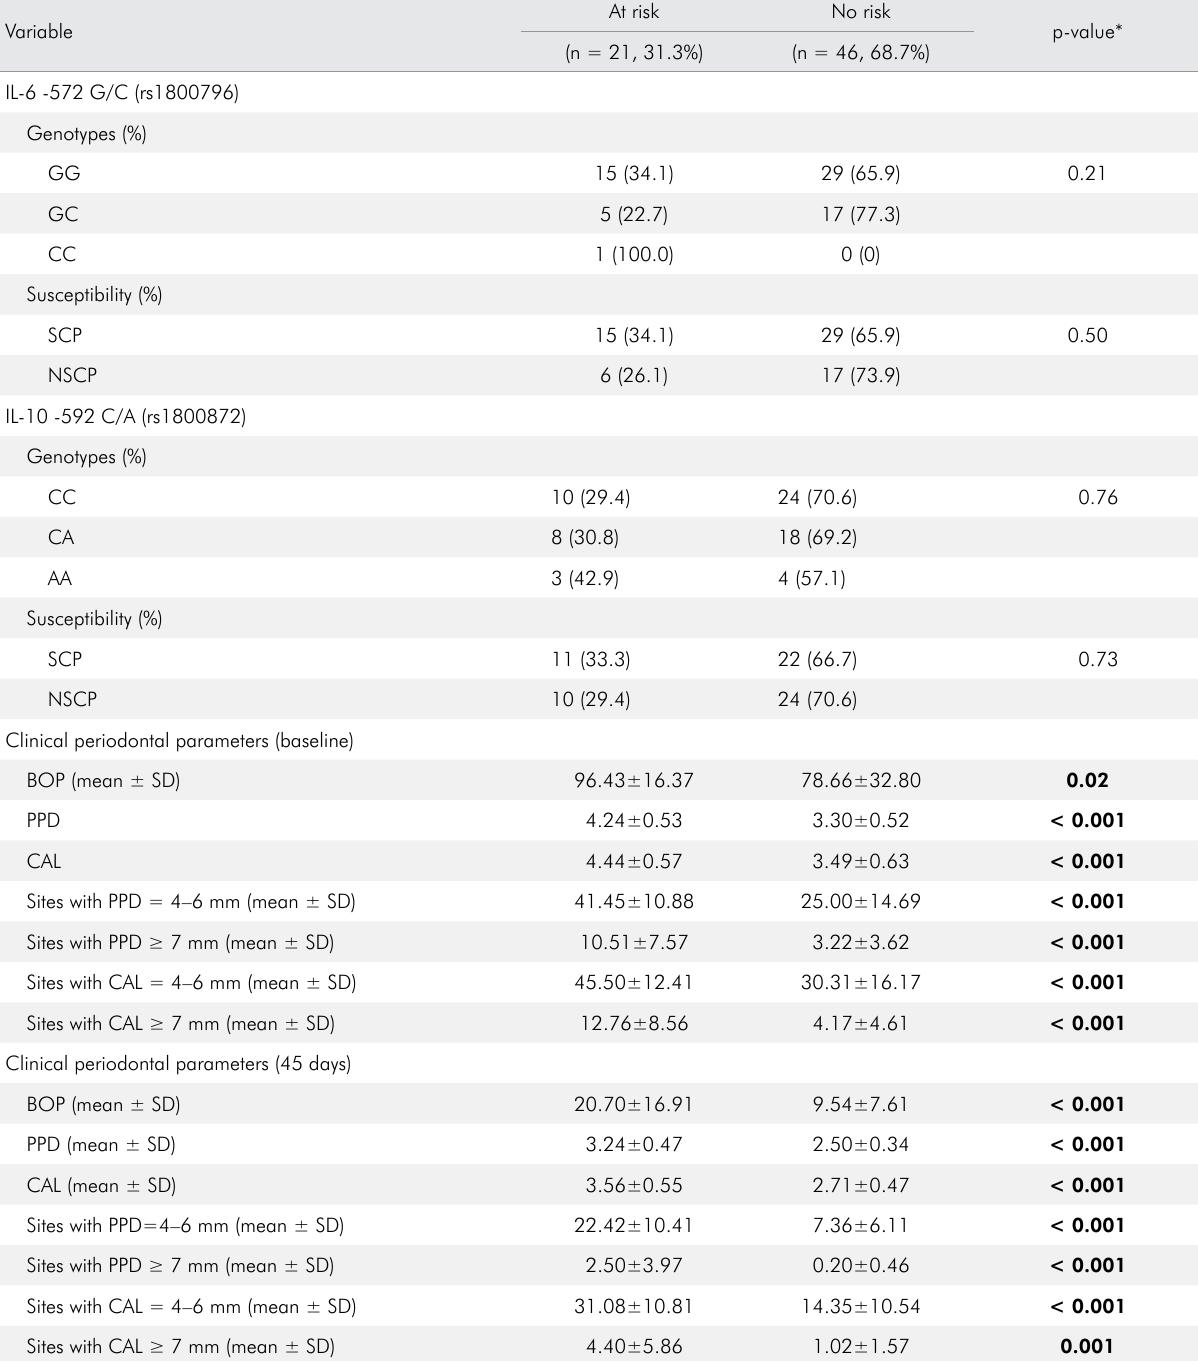
Table 3. Distribution of IL-6 -572 G/C (rs1800796) and IL-10 -592 C/A (rs1800872) genotypes as well as clinical periodontal parameters at baseline and the 45 th day following periodontal treatment among individuals at risk or not at risk of periodontal disease progression as determined by the presence of at least 9 sites with residual PPD ≥ 5